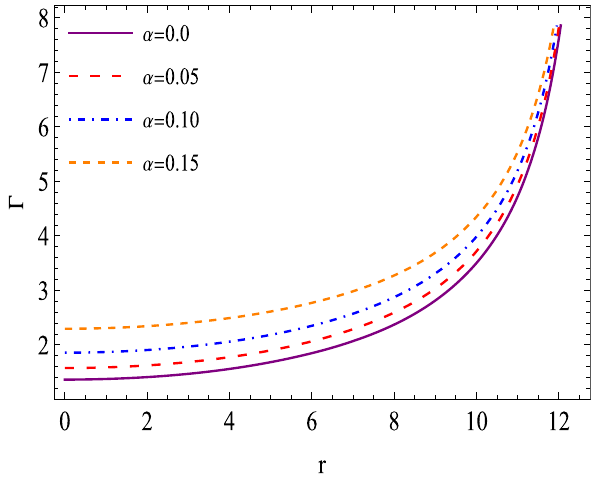
Fig. 4 The behavior of adiabatic index ( (cid:10) ) versus radial coordinate r with same constant values as used in